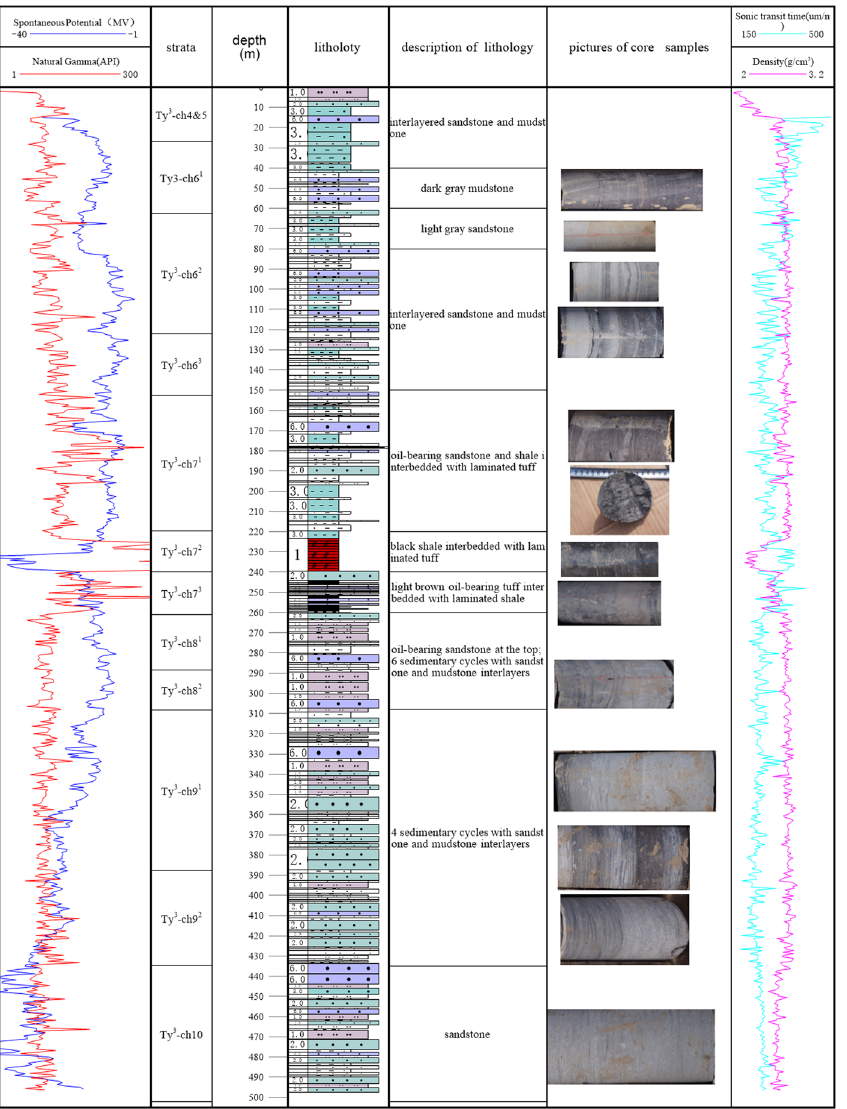
Figure 6. Lithological and electronic characteristics of the Yanchang Formation in well YK01. The photographs of the cores in this figure were taken in well YK01 by the corresponding author. Well YK01 is located in Yaoqu County, Tongchuan City, Shaanxi